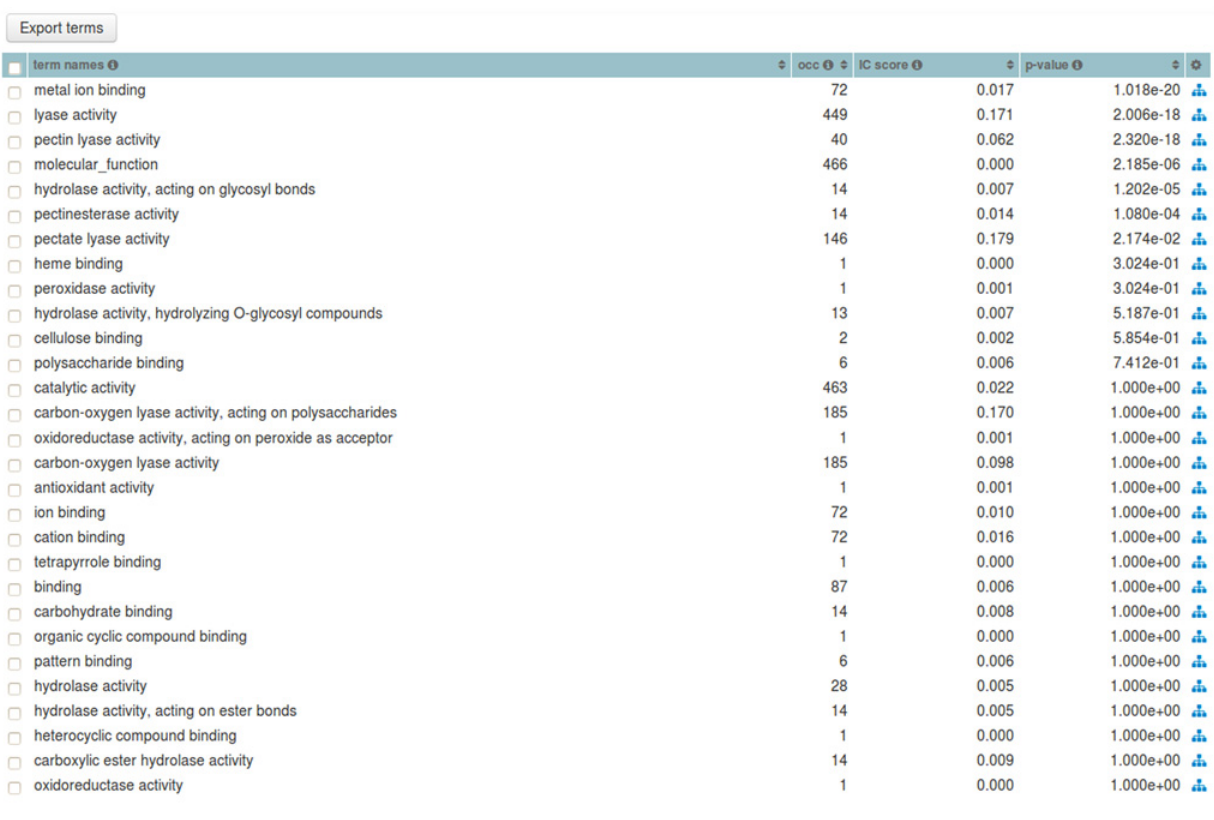
Fig 5. Term statistics for the PL1 Set. Footer table listing the molecular function GO term names and their respective statistics, such as, occurrence (occ), IC-based score and p-value for the PL1 (CAZy family)